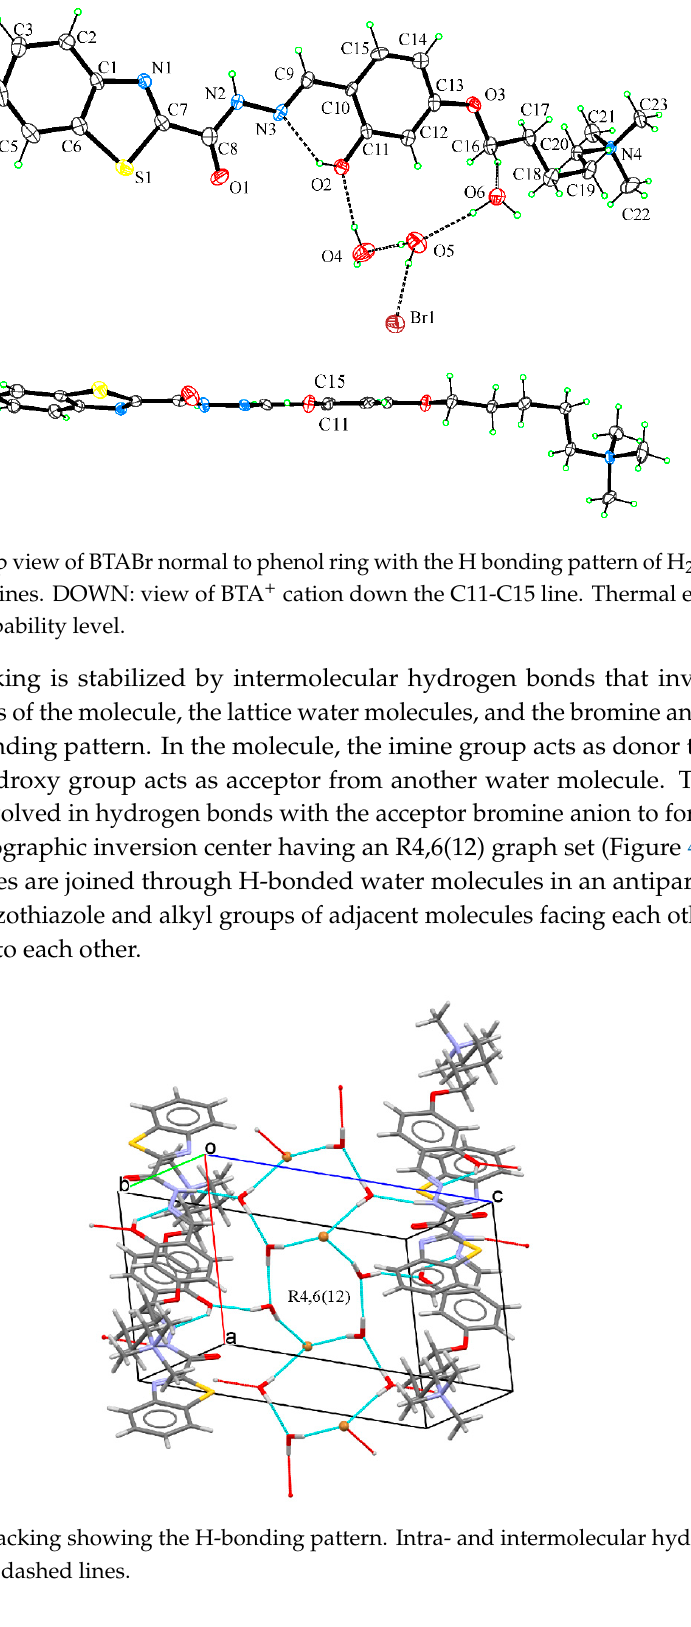
Figure 3. UP: Ortep view of BTABr normal to phenol ring with the H bonding pattern of H 2 O molecules drawn as dashed lines. DOWN: view of BTA + cation down the C11-C15 line. Thermal ellipsoids are drawn at 50% probability level.